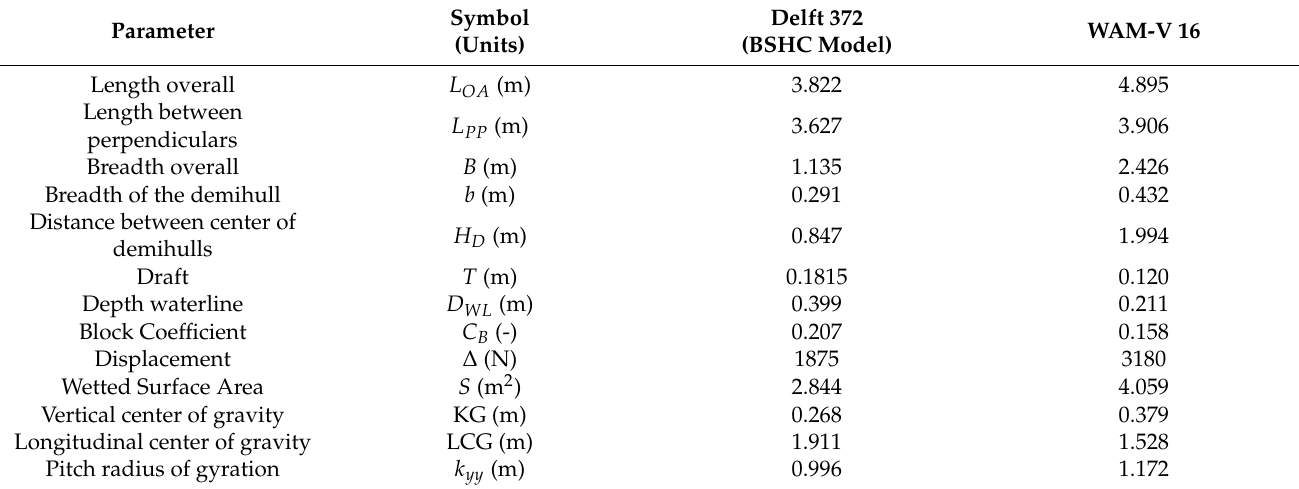
Table 1. Principal dimensions of the BSHC model Delft 372 and WAM-V 16